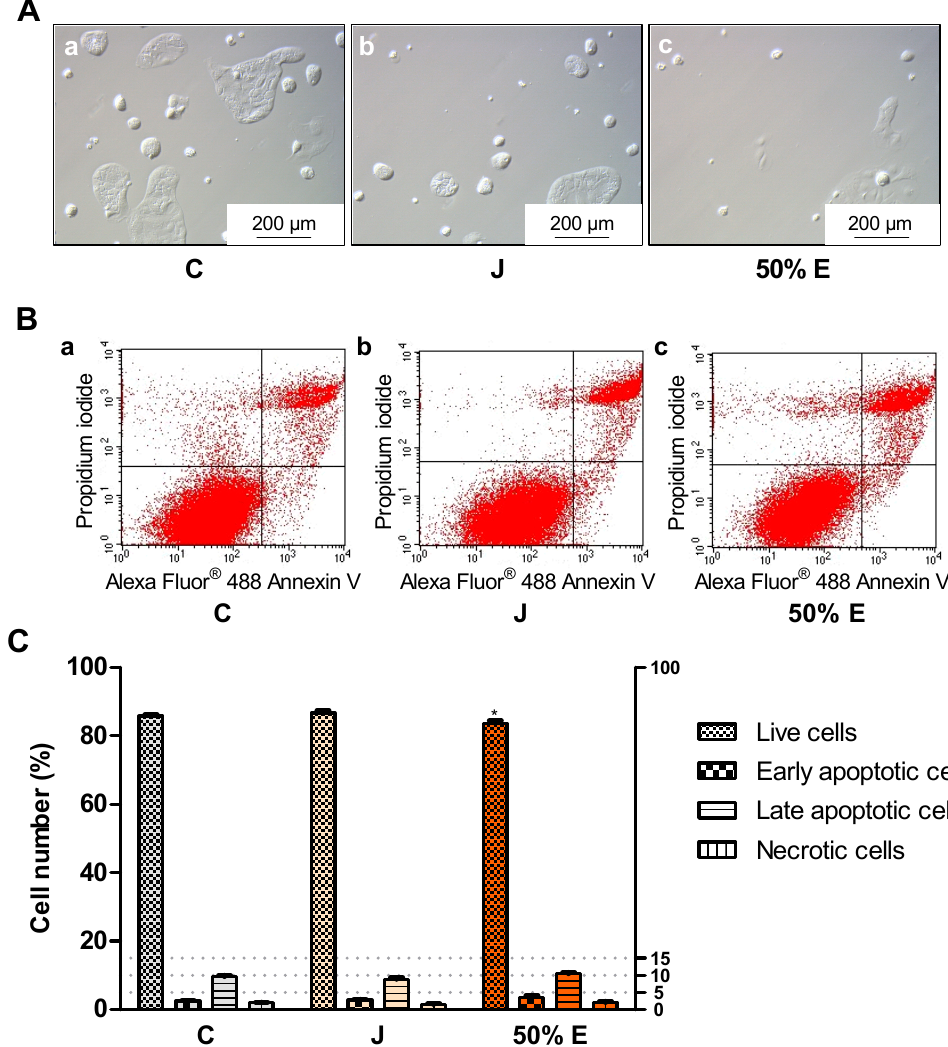
Figure 7. Types of death of Caco-2 cells after 72 h of treatment with juice (J) and 50% hydroethanolic extract (50% E) from Saposhnikovia divaricata root, at the concentration of 15.9 × 10 − 2 mg / mL. C—control cells (treated with deionized water). Panel ( A )—images from light microscope, panel ( B )—exemplary flow cytometry charts (lower left quadrant—live cells, lower right quadrant—early apoptotic cells, upper right quadrant–late apoptotic cells, upper left quadrant–necrotic cells), panel ( C )—graphs with error bars indicating standard error of the mean. Statistically significant effect: * represents values that differ from control at p < 0.05. n = 6.